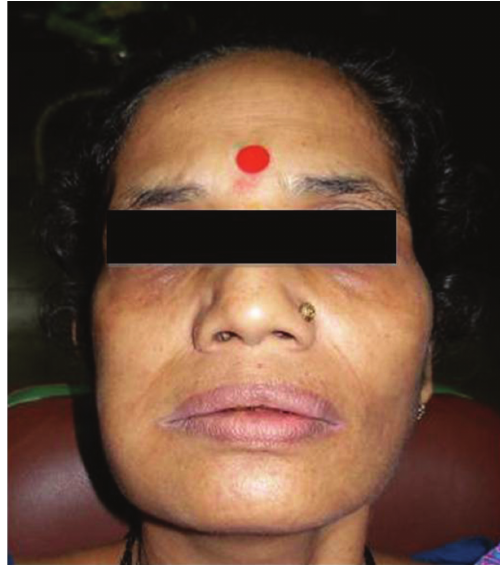
Figure 1: Extraoral examination revealed di ff use enlargement of lower right side of face over the angle and body of mandible.